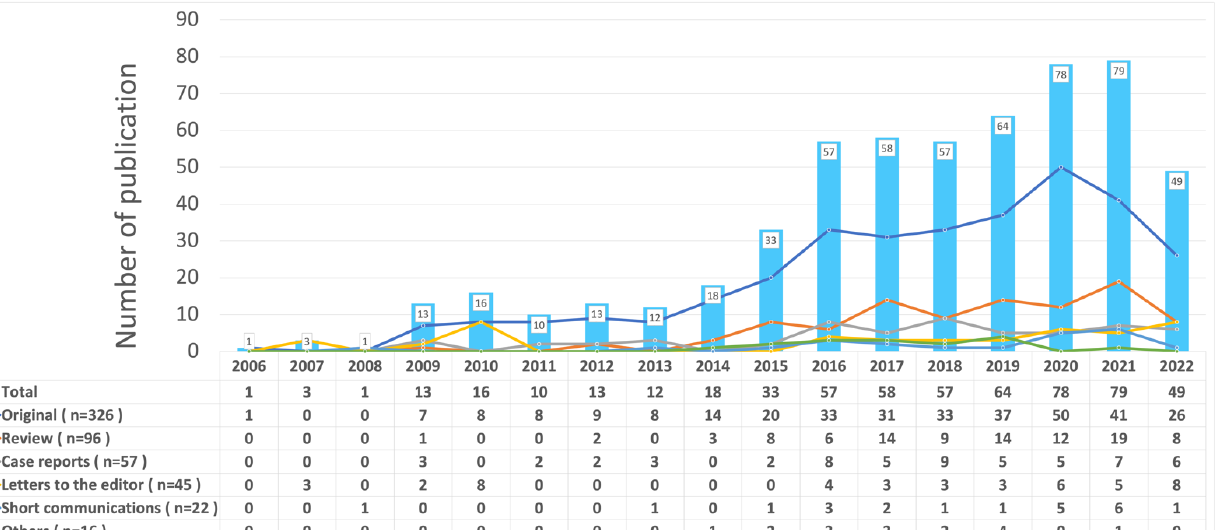
Figure 3. The annual production of PRF studies in different scope categories in dentistry. 3.2. Authors, Affiliations and Country Regarding the authorship productivity and total citation counts, the most frequently published corresponding authors were: Richard J. Miron (n = 18, 897 citations), David M. Dohan (n = 16, 2258 citations), Yu-Chao Chang (n = 11, 320 citations), Shahram Ghanaati (n = 9, 348 citations), and Avani Raju Pradeep (n = 9, 300 citations). In relation to the au- thors’ affiliations, the University of Bern contributed the maximum number of articles with 36 PRF related studies, followed by the University of Wuhan (n = 19), Katholieke Universiteit Leuven (n = 17), and Goethe University, Frankfurt (n = 14). The co-authorship network of affiliations published at a minimum of five articles is illustrated in Figure 4a. Concerning the country productivity, the co-authorship network of countries is de- picted in Figure 4b. W ith the corresponding author’s origin counting method being used, Asia (n = 296, 52.67%), Europe (n = 155, 27.58%), and South America (n = 46, 8.19%), were the three major continents which published the highest total number of articles in the world. As Figure 5. demonstrates, the five main countries contributing the highest total number of publications were Turkey (n = 91, 16.19%), India (n = 69, 12.28%), China (n = 40,